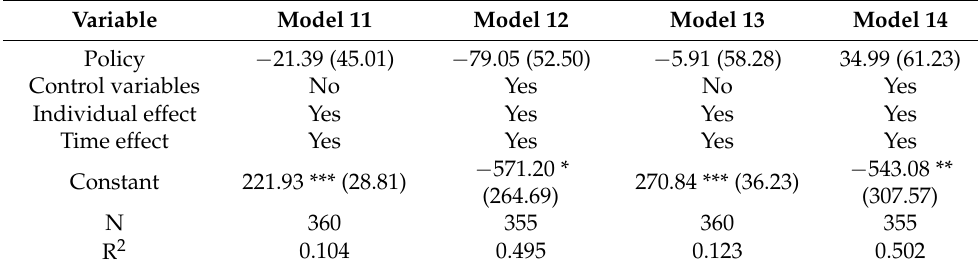
Table 7. Results of the counterfactual